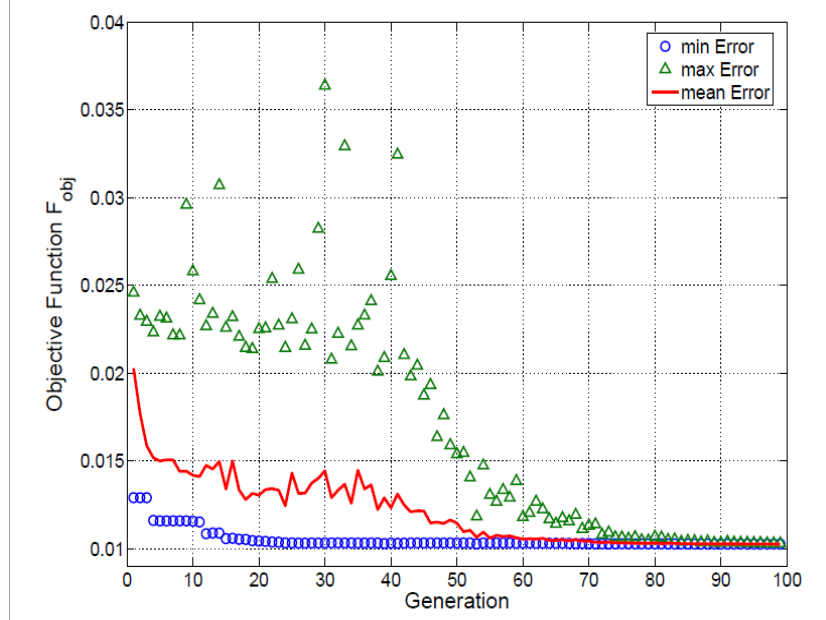
Figure 8. Evolution of the Genetic Algorithm as a function of